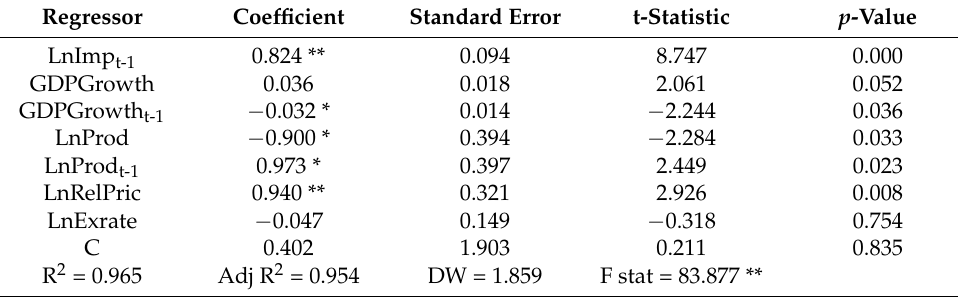
Table 5. The estimated results of the ARDL (1,1,1,0,0) model.